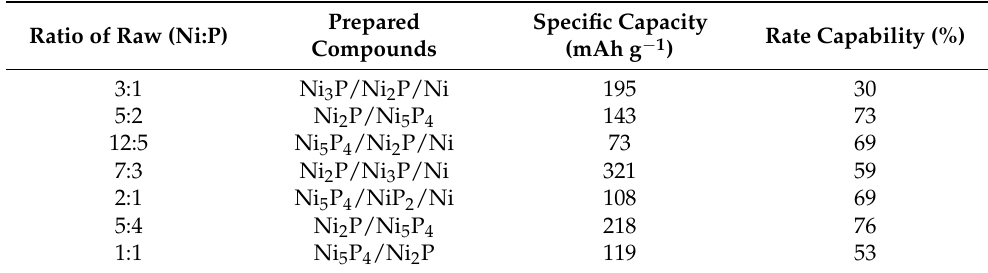
Figure 6b is the cyclic voltammetry curve of various Ni/P ratios at 3 mV s − 1 . The area is the largest when the ratio of nickel to phosphorus is 7:3, followed by a ratio of 5:4, which corresponds to its specific capacity. From the platform of the